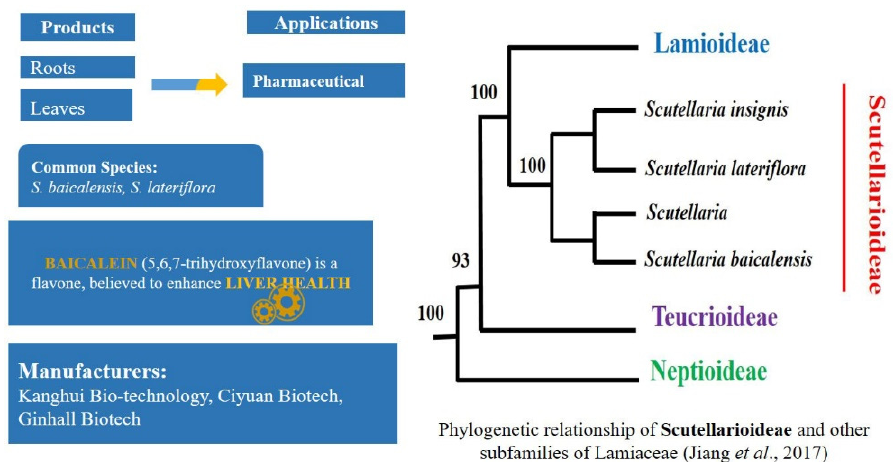
Figure 6. Skullcap products, applications and phylogenetic relationship among the species of Scutellarioideae and other subfamilies of Lamiaceae.